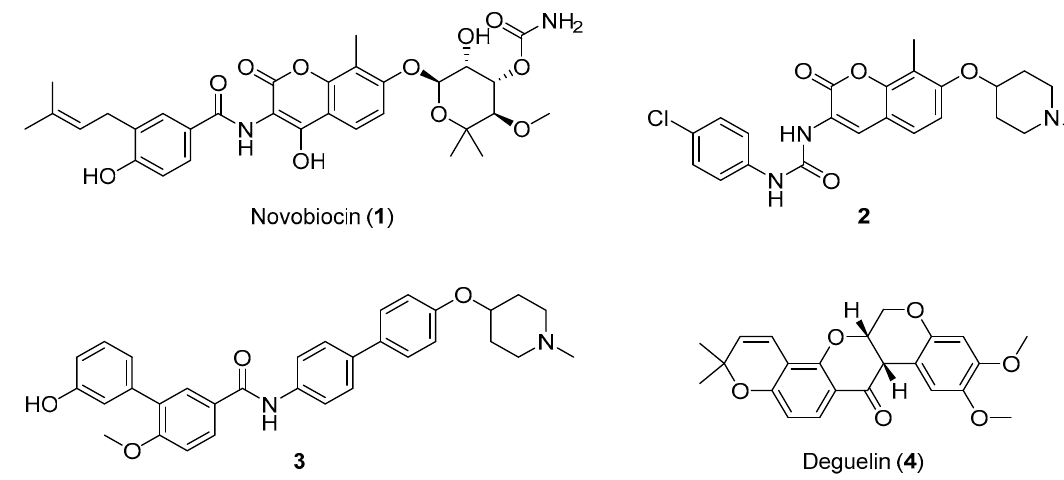
Figure 1. Representative Hsp90 C-terminal domain inhibitors. First Hsp90 C-terminal domain (CTD) inhibitor 1 (IC 50 ~700 μ M SKBr3 cancer cells) [17,21], synthetic novobiocin derivatives 2 and 3 (IC 50 < 1 μ M SKBr3 cancer cells) [22,23] and deguelin ( 4 ), a flavin natural product.